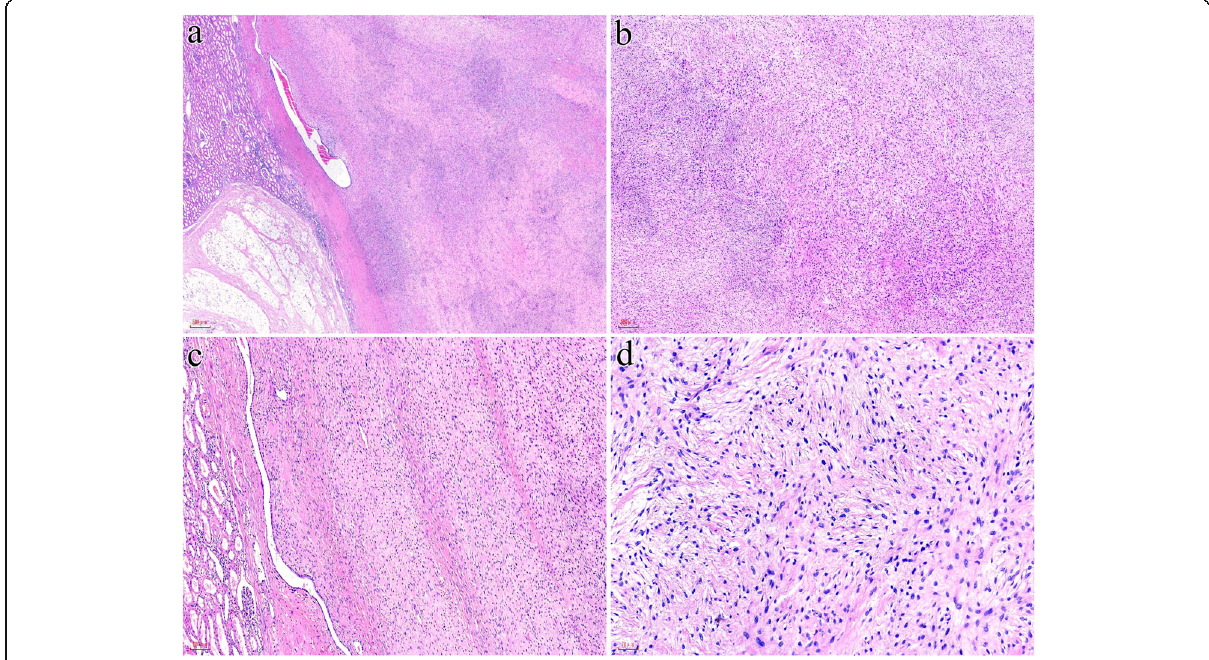
Fig. 2 Microscopically, the tumor was unencapsulated with focally entrapped benign renal tubules ( A ). The tumor cells were arranged in interwoven fascicles or storiform patterns in a myxoid to collagenous matrix ( B, C ). The tumor cells were elongated, spindle-shaped cells with ovoid to tapering, bland-appearing nuclei ( D